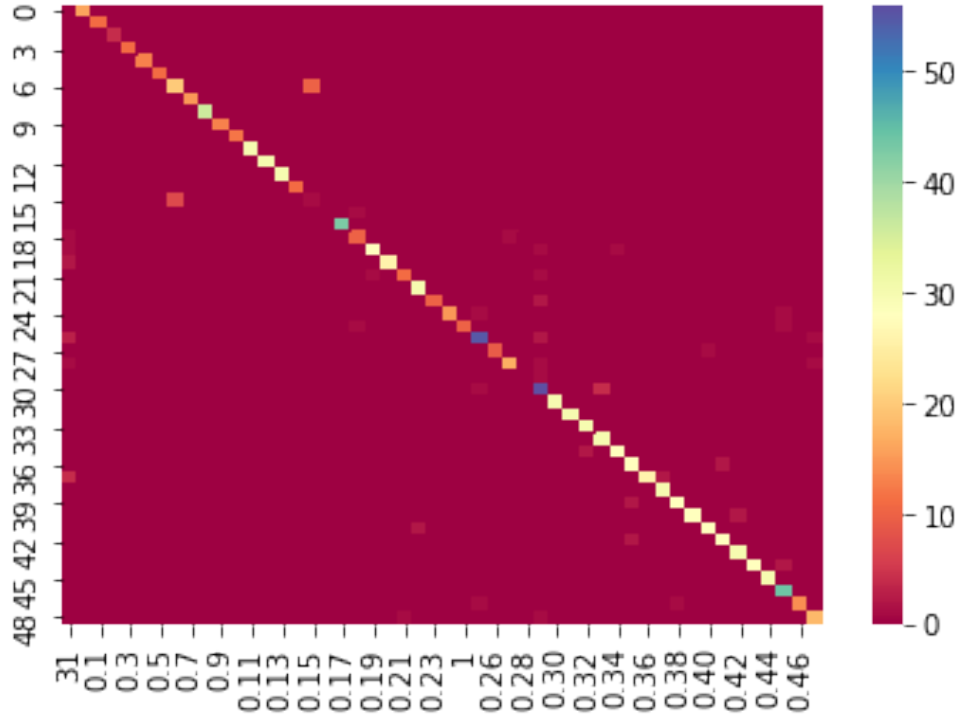
Figure 10. The heat map obtained for the proposed